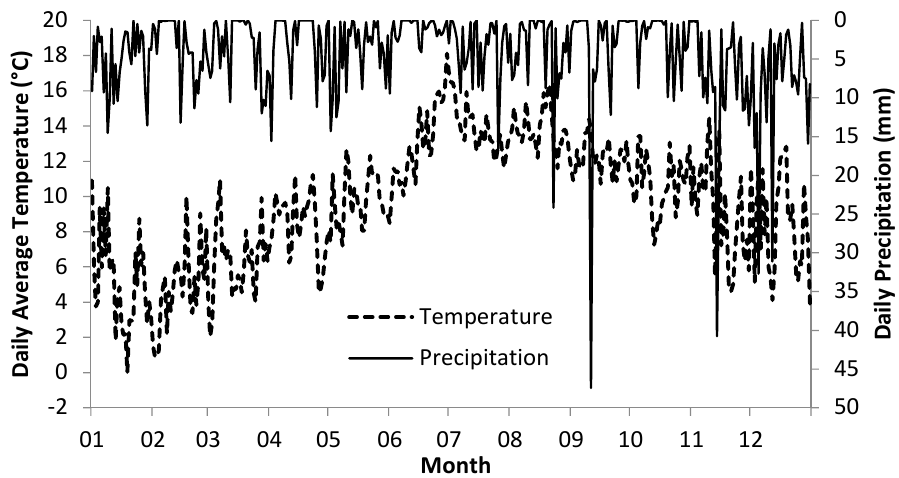
Figure 3. Daily average temperatures and daily total precipitation (mm) from January to December, 2015. These readings are taken from averages of two Met Eireann synoptic weather stations (See Figure 2).